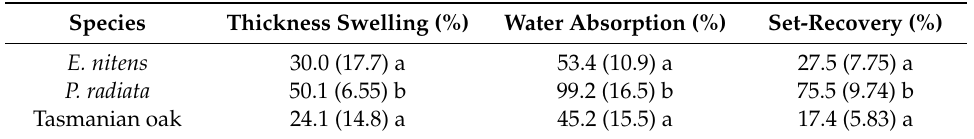
Figure 4. Dimensional change of the samples in each state, before the treatment, at the target thickness, after the densification (both at initial 4% MC and at oven-dried 0% MC), after soaking and at the final soaked and dried thickness (mm). Table 5. Average values of thickness swelling (%), water absorption (%), and set-recovery (%) of the three species. Standard deviation presented in parentheses ( n =